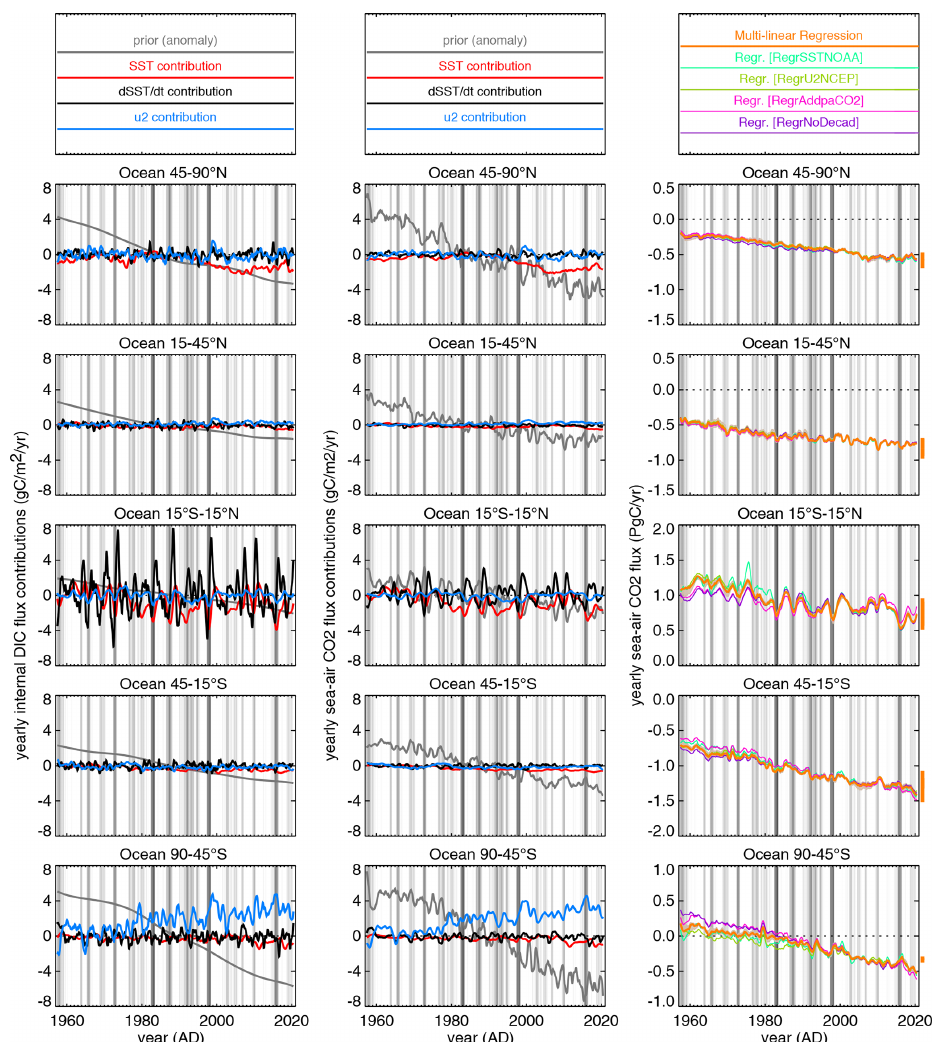
Figure 3. Left: estimated contributions of the three explanatory variables in the multi-linear regression (as well as the prior, plotted here without its mean) to the ocean-internal DIC flux in five latitudinal bands (top to bottom). Centre: corresponding contributions to the sea–air CO 2 flux. Right: total sea–air CO 2 flux estimated by the multi-linear regression (base case, orange) together with the uncertainty cases listed in Sect. 2.2 (the cases with the largest impact on interannual variability – RegrSSTNOAA, RegrU2NCEP, RegrAddpaCO2, RegrNoDecad – are plotted explicitly in different colours; since the cases related to gas exchange – GasexLow, GasexHigh, GasexU1, GasexU3 – shift the long-term mean of the flux, the range of this shift has been indicated by the length of the vertical orange bars just to the right of each panel for clarity; the remaining uncertainty cases having rather small impact – RegrAdddSSTdt2, RegrAddU4, RegrLoose, RegrShort, MLDq2, MLDx2 – have been subsumed into the pale orange band depicting their envelope). All curves show interannual variations. The background shading indicates the El Niño phase according to the multivariate El Niño index (MEI) by Wolter and Timlin (1993). In the left and centre panels, fluxes are given in per-area units to emphasize the local process perspective, while fluxes in the right panels are given as regional integrals to emphasize their share in the total ocean